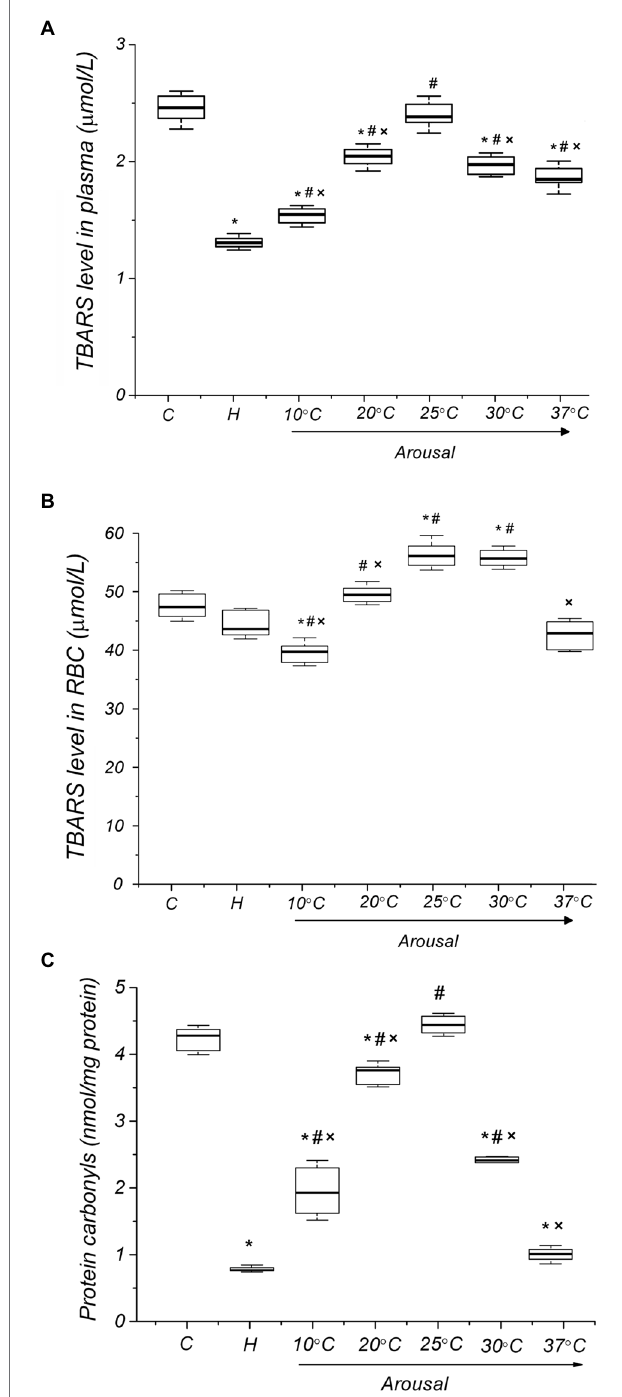
FIGURE 4 | Level of oxidative modification products of lipids and proteins of blood plasma and RBC membranes in ground squirrels during arousal from hibernation. Plasma TBARS dynamics (panel A ), TBARS in RBCs (panel B ) and carbonyl groups in RBC membrane proteins (panel C ) during torpor and arousal ( n = 6). C, control; H, hibernation; and body temperature ( ° C). Data are presented as box plots that show the median, 25/75 percentiles (box), and 10/90 percentiles (bars). * p < 0.001, compared with C; # p < 0.001, compared with H; × p < 0.001, compared with Tb 25 °